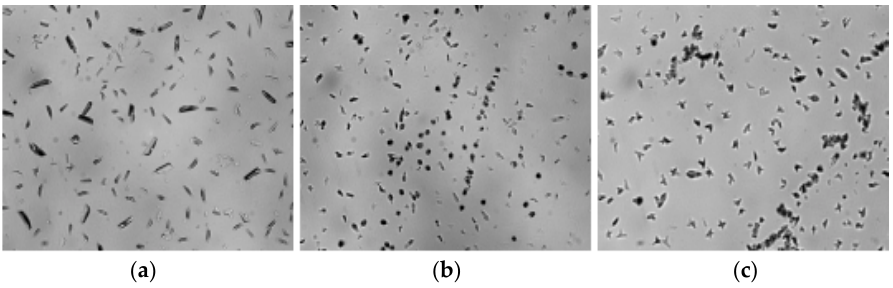
Figure 6. The polarizing microscope photographs of PLA/zeolite-4 ( a ), PLA/zeolite-6 ( b ) and PLA/zeolite-8 ( c ) amplified 100 times.